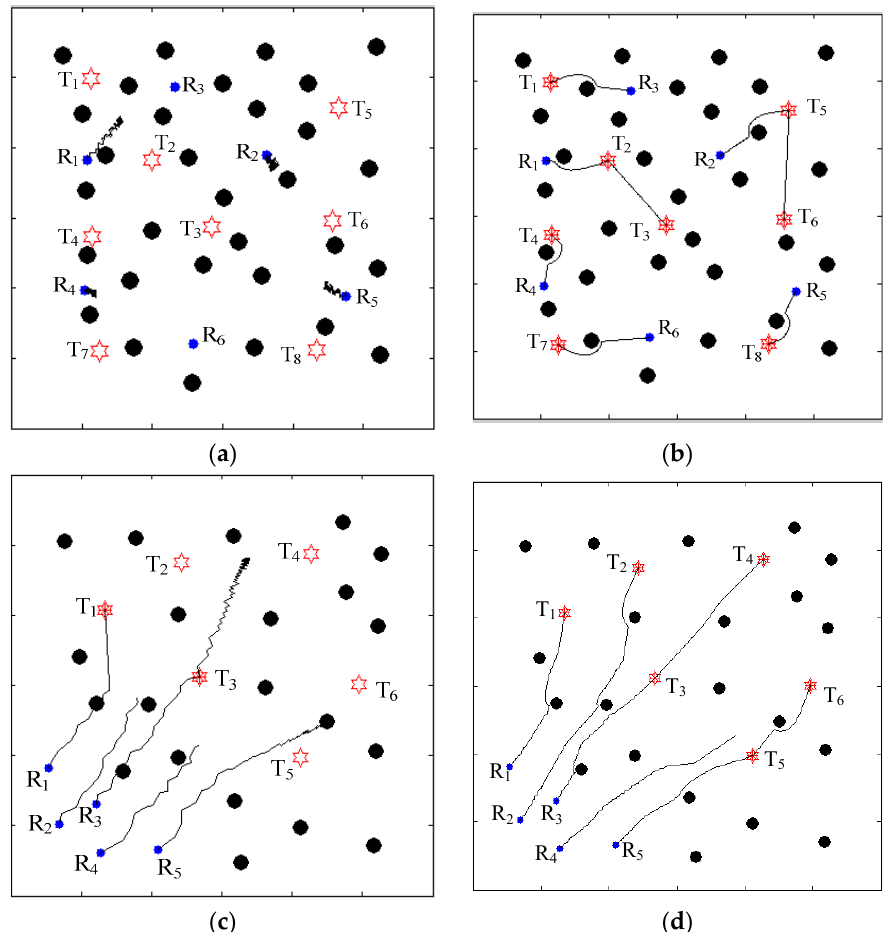
Figure 8. Problem of some robots exhibiting oscillation and hovering. ( a ) The traditional SOM algorithm for the robots’ random distribution; ( b ) DSOM for the robots’ random distribution. ( c ) The traditional SOM algorithm for the robots’ aggregation; ( d ) DSOM algorithm for the robots’ aggregation.